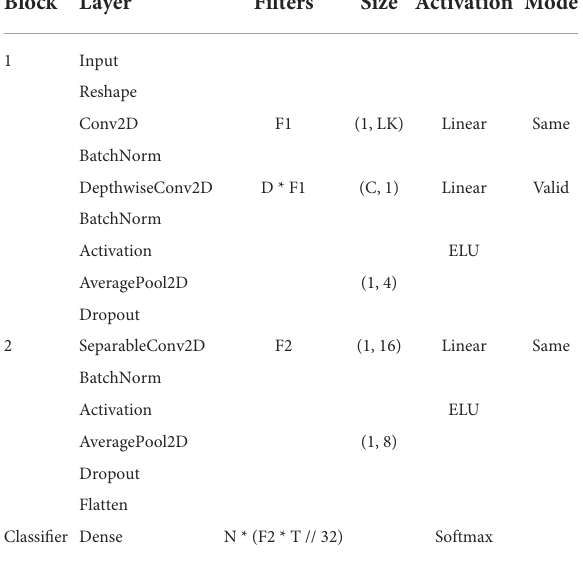
TABLE 1 EEGNet architecture based on convolutional block, the output from previous bloc neural networks. Block